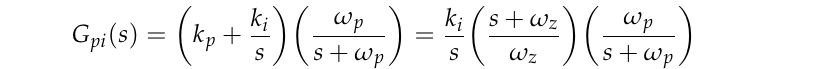
Figure 7. Per module and per phase model of the control loop.